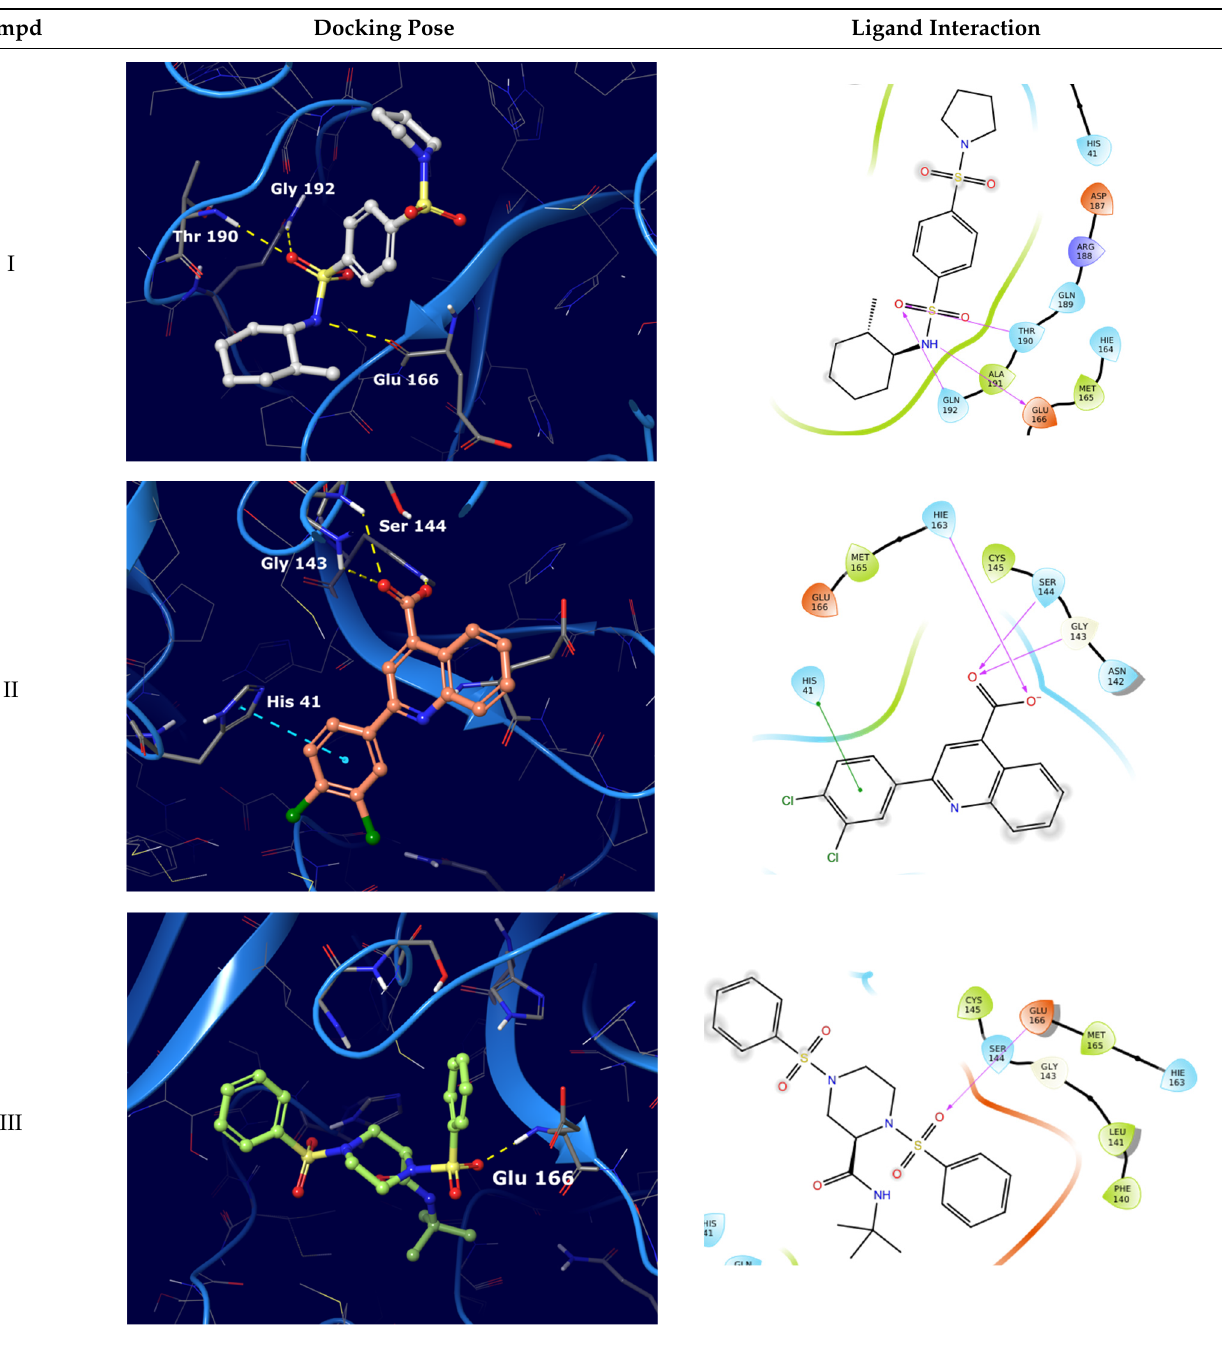
Table 7. 2D structure and binding mode of the five consensus prioritized compounds versus the viral Mpro retrieved by docking calculations. Purple arrows represent H-bond interactions, blue lines surrounding the molecules underline non-polar regions and orange lines highlight negative charge residues, whereas green lines point polar residues.